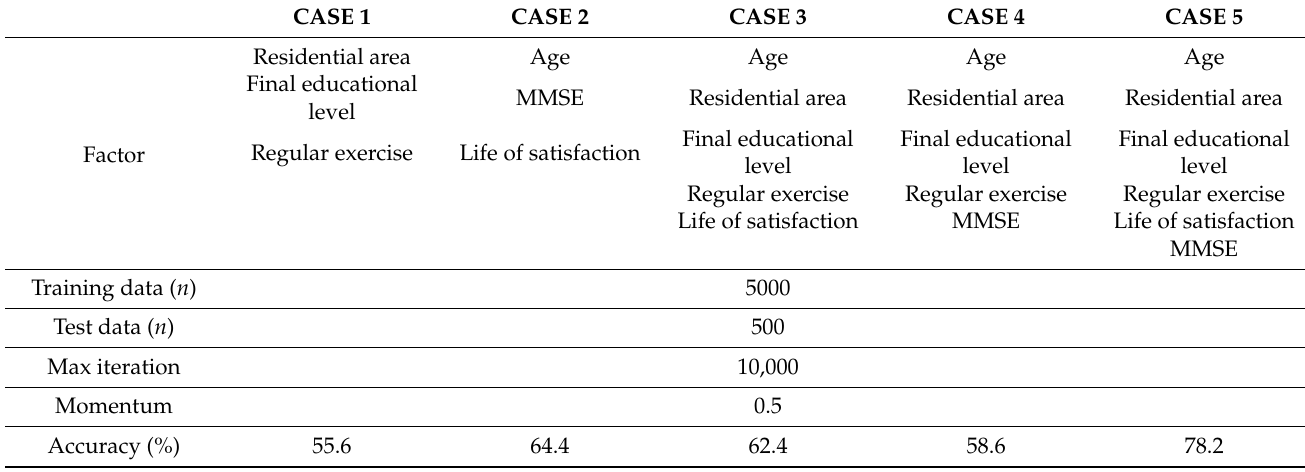
Table 4. Accuracy of the factors affecting